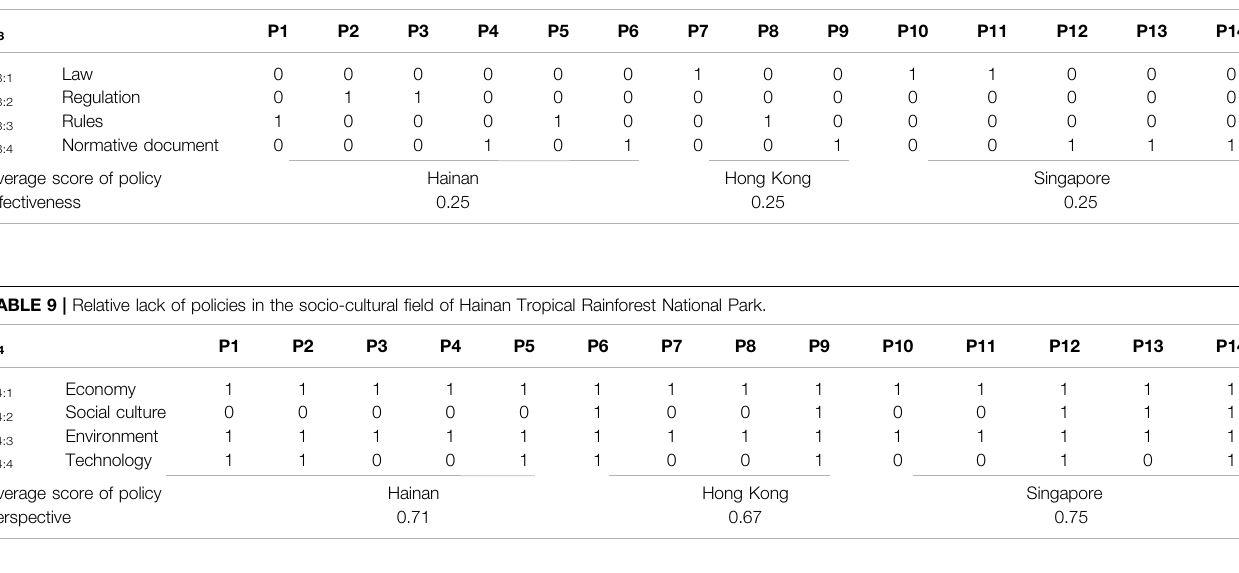
TABLE 8 | Relatively low policy effectiveness of Hainan Tropical Rainforest National Park.